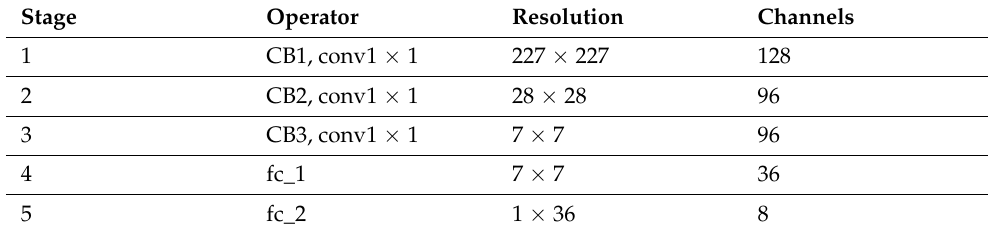
Table 1. Model B1.